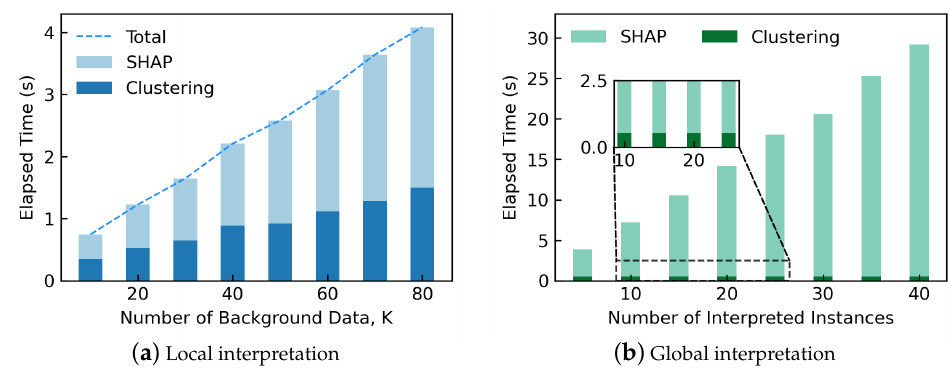
Figure 8. Time consumption of